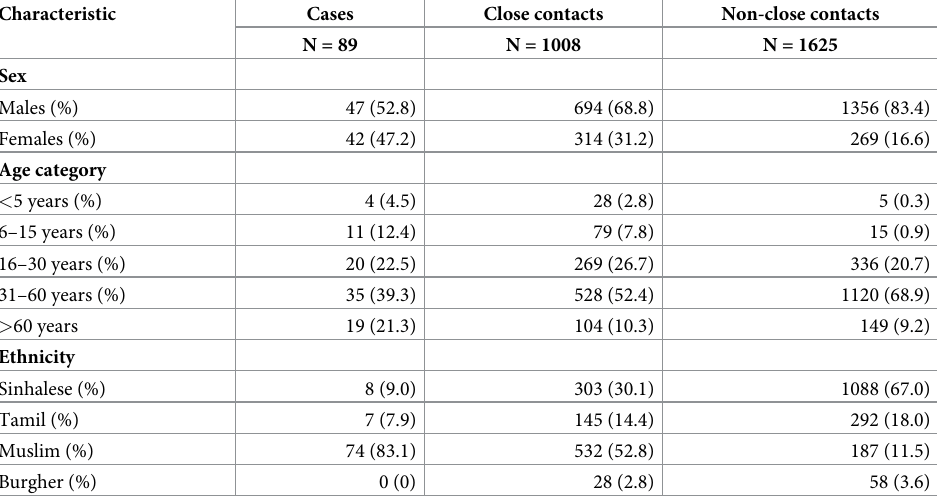
Table 1. Demographic characteristics of the infected individuals and their contact.